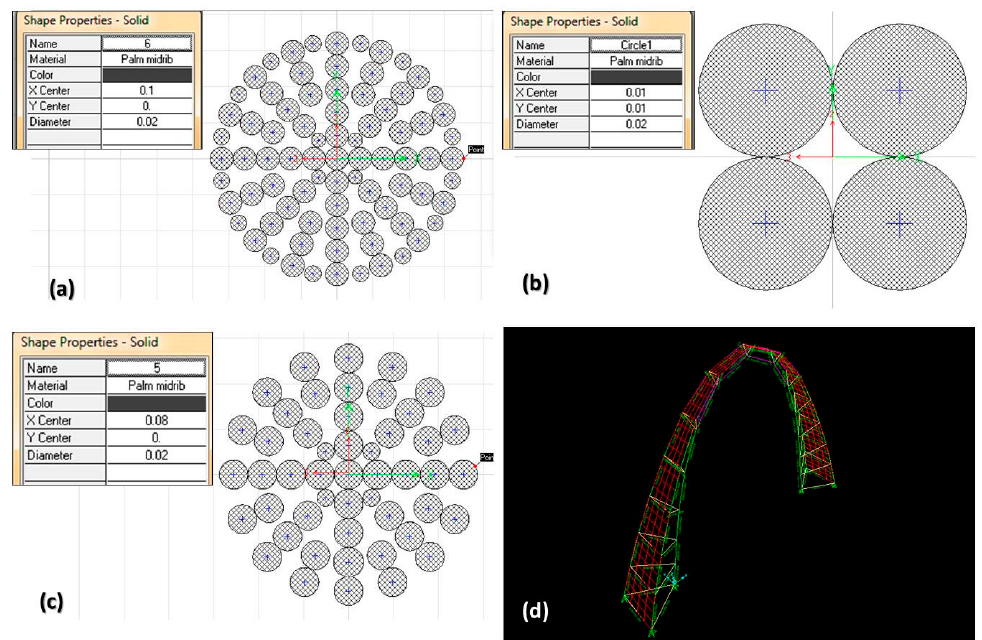
Figure 30. The setup of the digital model of the system in SAP2000. ( a ) Cross-section of the bottom bundle. ( b ) Cross-section of the bracings. ( c ) Cross-section of the middle bundle. ( d ) Initial form of the system.